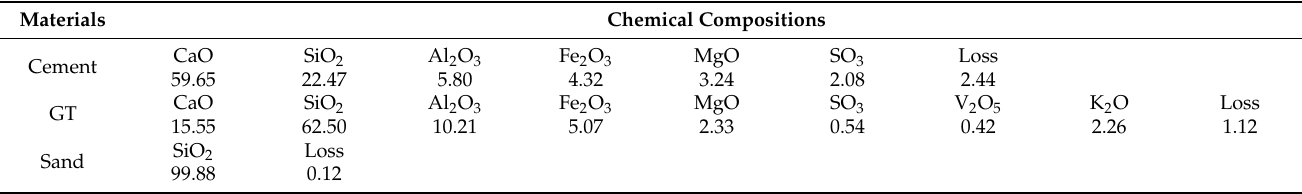
Figure 1. ( a ) Material appearance, ( b ) particle size distribution, ( c ) granular gradation of GT and sand. Table 2. Chemical properties of Portland cement, sand and graphite tailings (%).